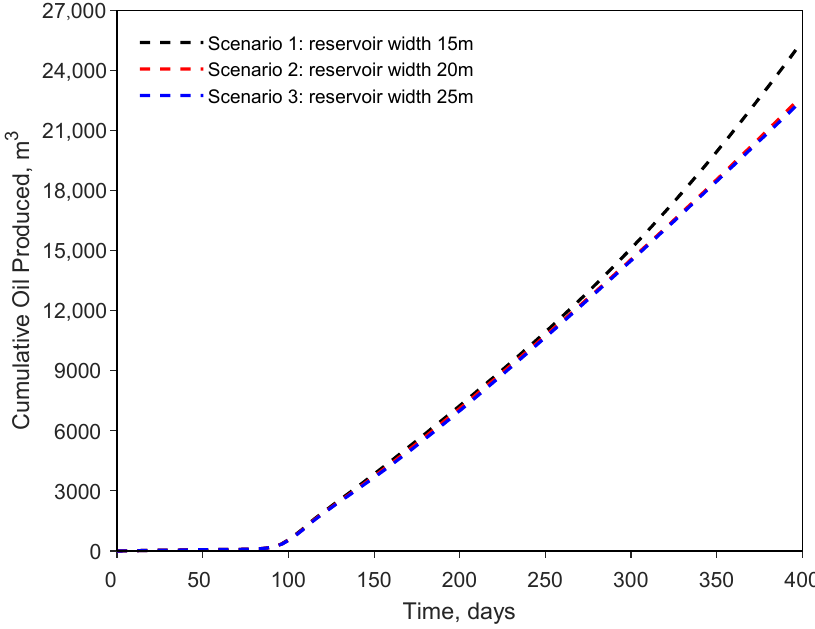
Figure 6. Cumulative oil production of scenarios 1 to 3 under varying reservoir widths.